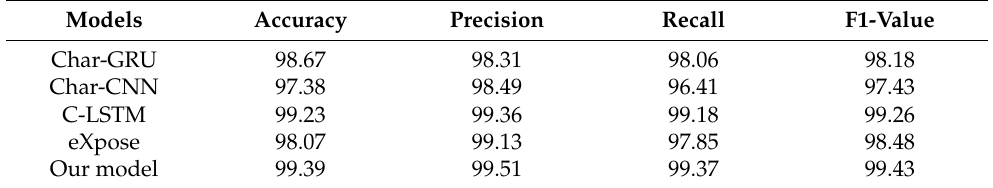
Table 10. The comparison of our model based on feature fusion and other classification models (%). Models